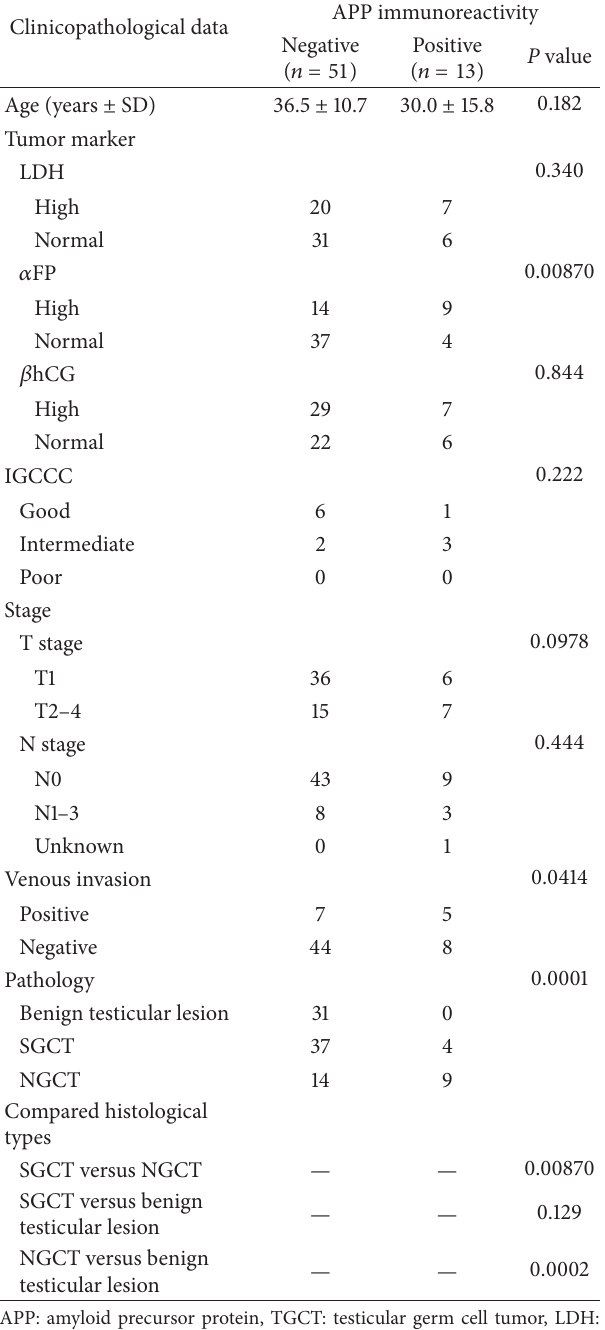
Table 2: Relationships between APP immunoreactivity and clinico- pathological characteristics in TGCT patients ( 𝑛 = 64 ).